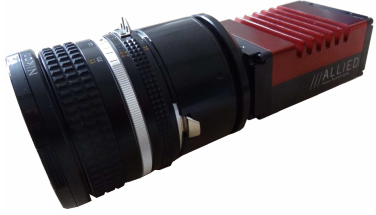
Figure 4: Prosilica GT3300C RGB